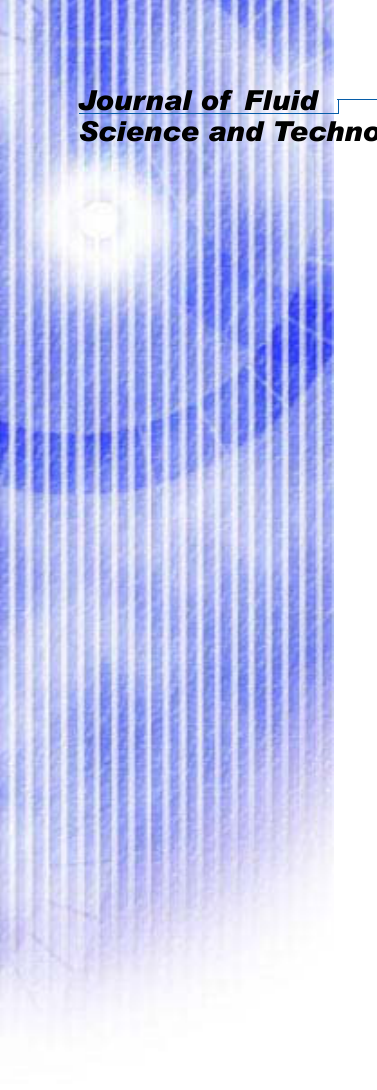
to 0.3, is also shown in Fig. 7. The chained line is not in agreement with our experimental data. Hu et al. developed the semiempirical Eq. (4) to calculate the backlayering distance in a tunnel fire. The equation is based on Thomas’ theory, according to which the backlayering distance depends on the buoyancy of the thermal fumes and the inertial force by the longitudinal ventilation wind, and the empirical relationship of temperature in a tunnel fire.